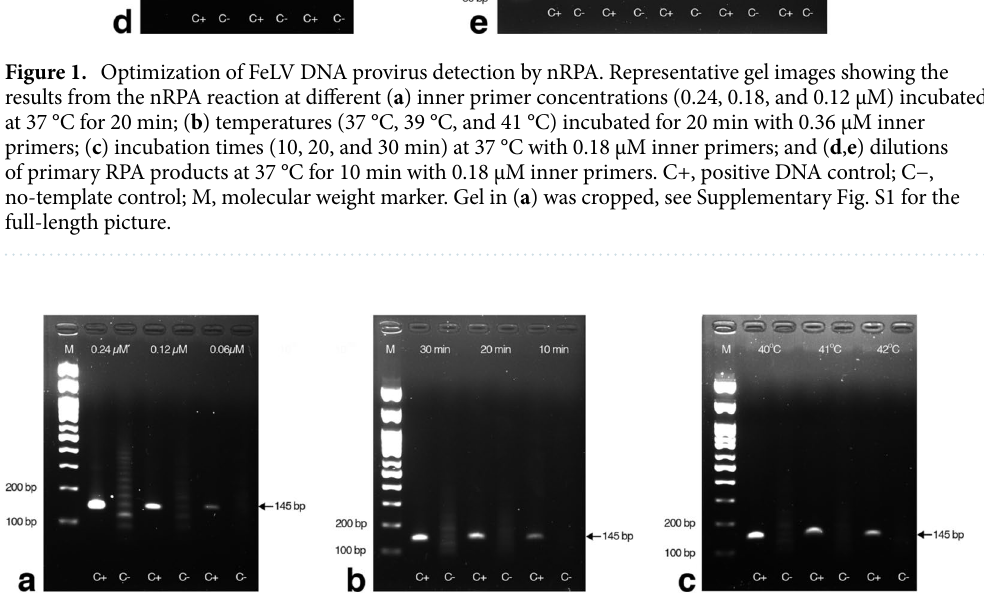
Figure 2. Optimization of FeLV RNA detection by RT-RPA. Representative gel images showing the results from the RT-RPA reactions at different ( a ) primer concentrations (0.24, 0.12, and 0.06 µM) incubated at 40 °C for 20 min; ( b ) incubation times (10, 20, and 30 min) at 40 °C with 0.12 µM primers; and ( c ) temperatures (40 °C, 41 °C, and 42 °C) for 10 min. C+, positive DNA control; C−, no template control; M, molecular weight marker.